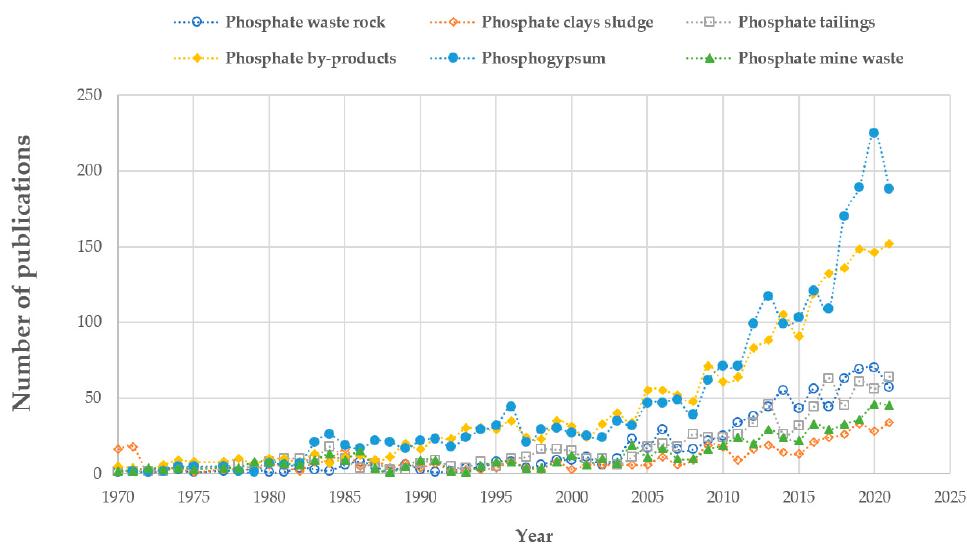
Figure 3. Number of publications dealing with the different phosphate waste streams in the last 50 years (data gathered from Scopus).